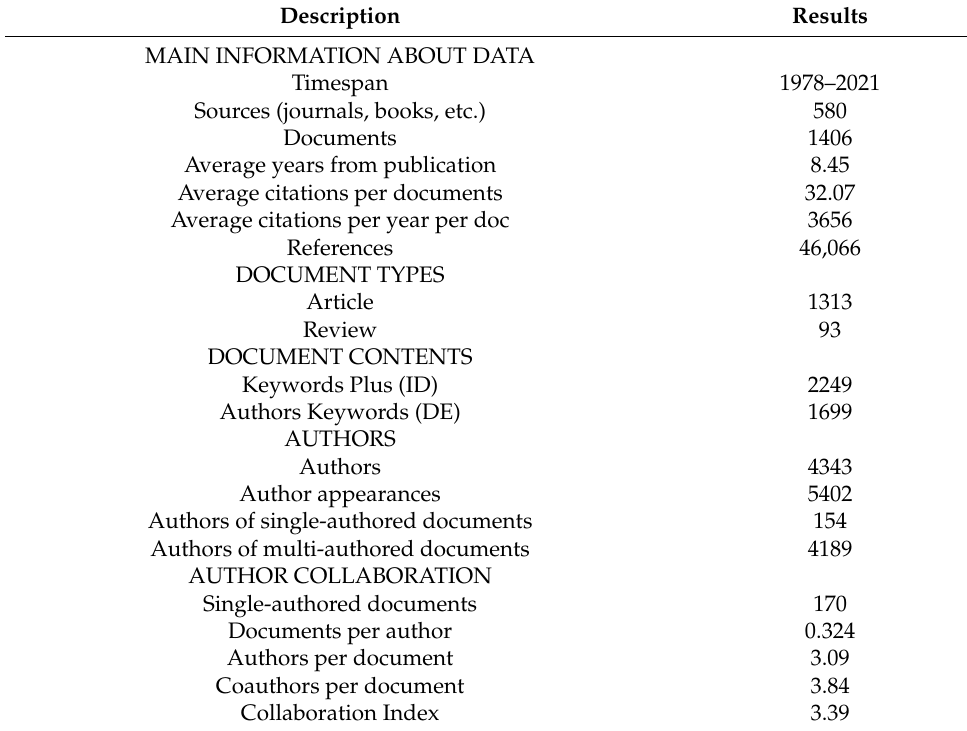
Table 1. Main information about the bibliometric